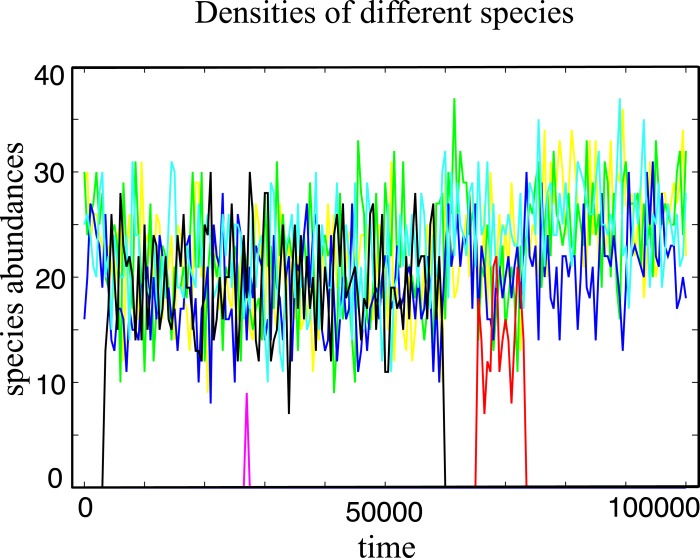
Typical evolutionary trajectory of a single community.The community starts with only one species, and after it evolves in 107 generations we record the number of individuals for every species in the next 105 generations. In this time window, we have around 4 spontaneous mutations in total. Some of them go extinct in a short time and some of them (e.g., the black line and the red line) coexist with other species for a long time period under strong selection. The Parameter sets: N = 100, w = 10, M = 3, Mcons = 2, RMax = 30 and ν = 5 × 10−7.